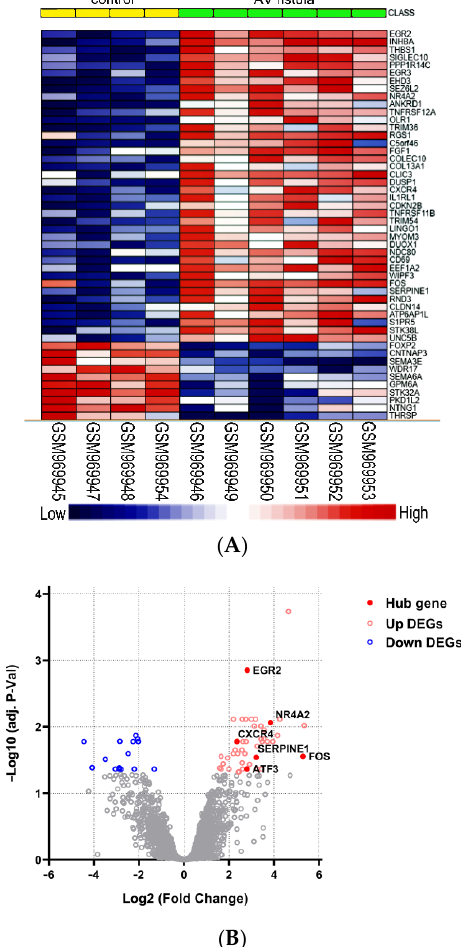
Figure 4. Identification of DEGs between control and AV fistula groups: ( A ) heatmap showing the top 50 DEGs between two groups; ( B ) volcano plot showing the DEGs between two groups after analysis using RStudio software. The red circles indicate upregulated genes, blue circles indicate downregulated genes, and the gray circles indicate genes which were not statistically different. DEG: differentially expressed gene.